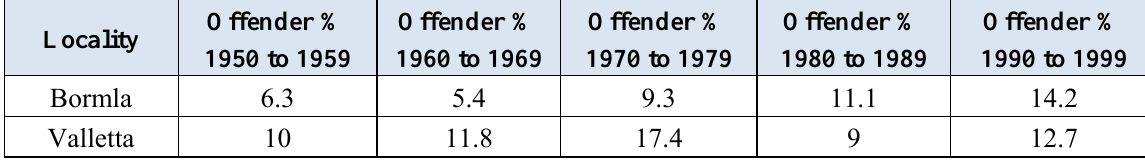
Table 1. Offender Residence Changes: